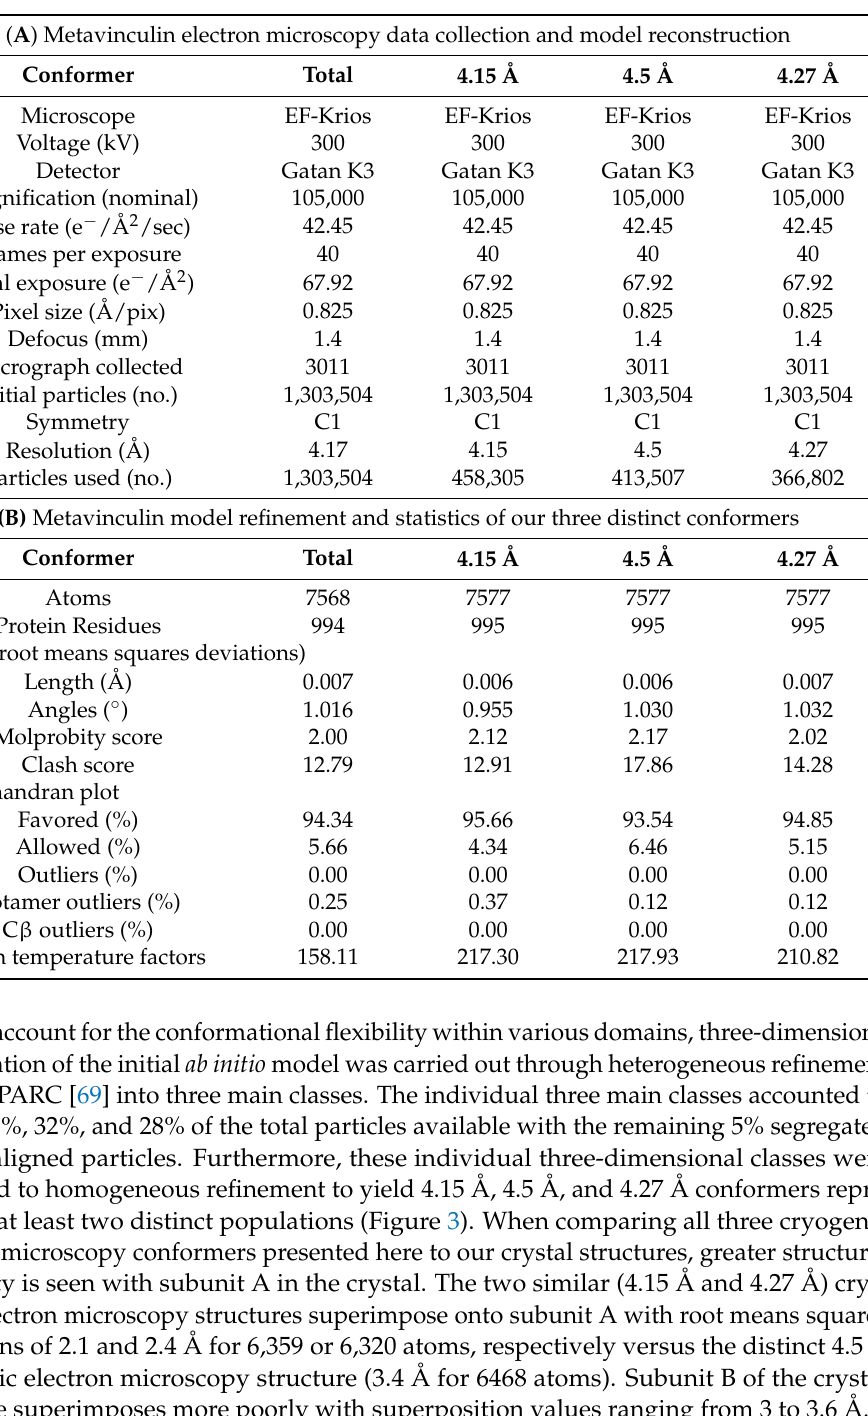
Table 1. Metavinculin cryogenic electron microscopy data collection and model